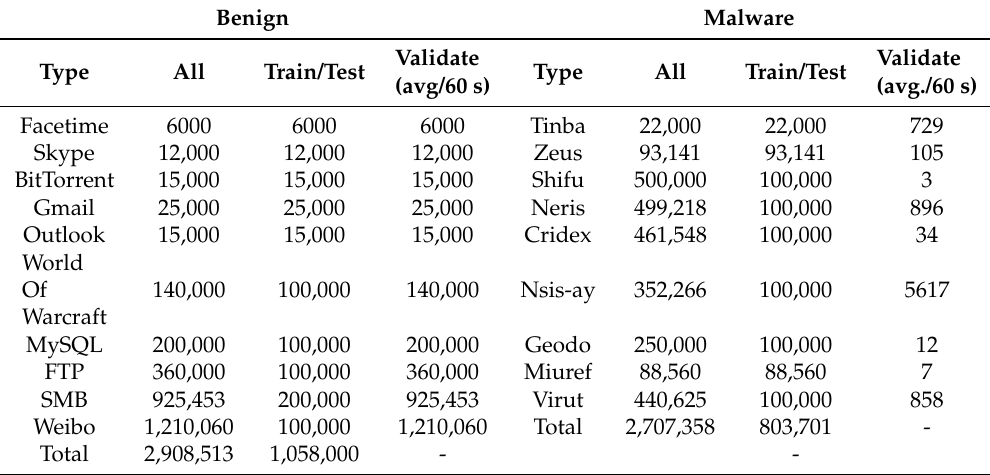
Table 7. Train/Test/Validate traffic proportion in the USTC-TFC-2016 dataset.